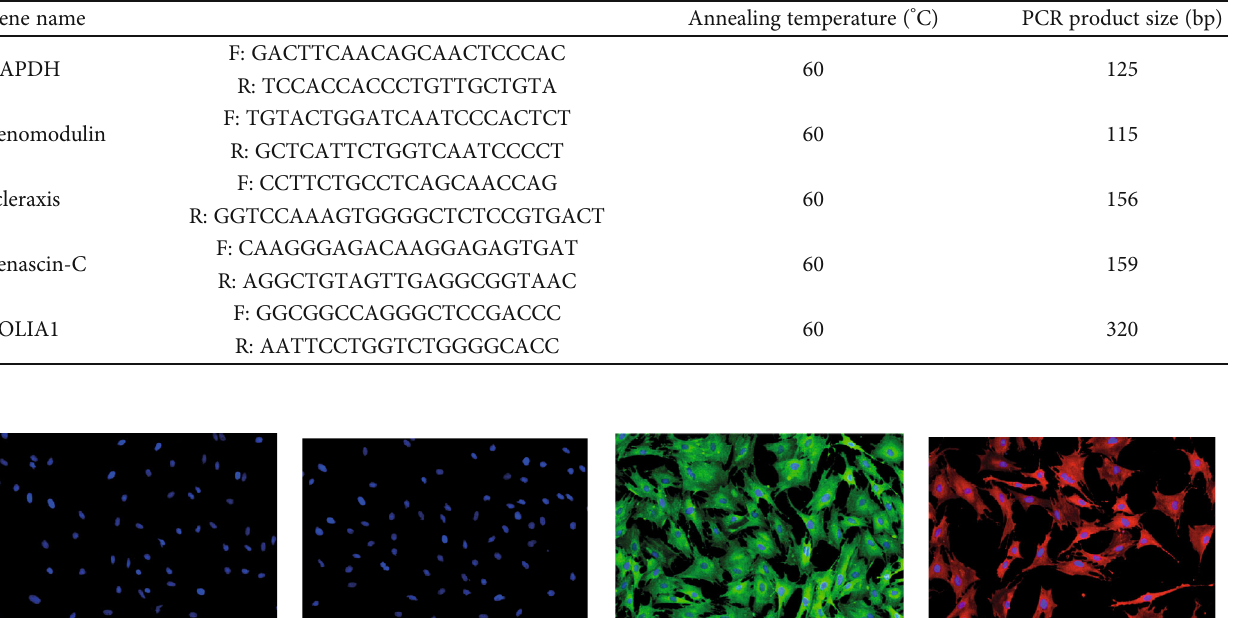
Table 1: Primers used in qPCR analysis.